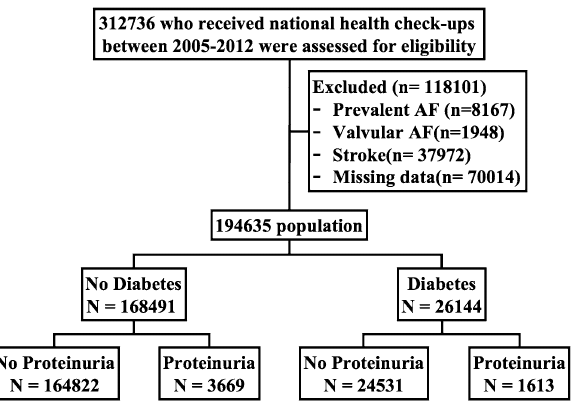
Figure 1. Flowchart of the study population enrollment and